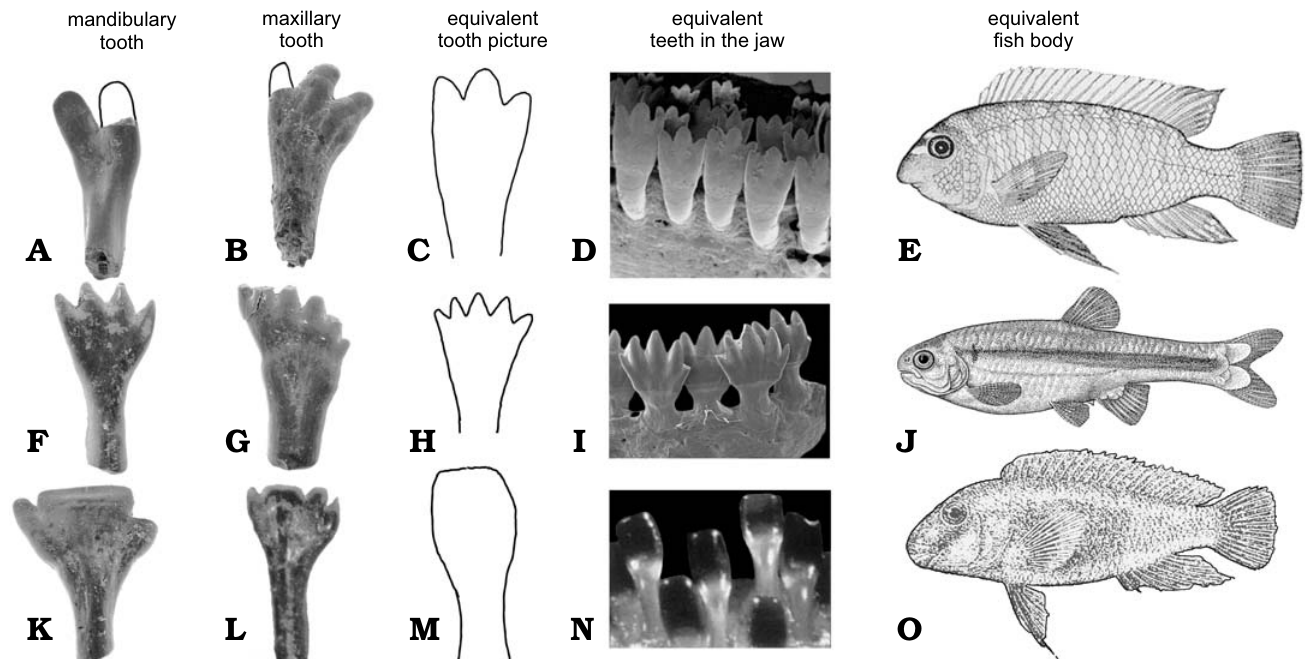
Fig. 3. Comparison of teeth of actinopterygian fish Isadia spp. from the Late Permian of Sokovka, Russia with their Recent equivalents. A , B . Isadia aristo viensis . C–E . Labeotropheus fuelleborni (C from Streelman et al. 2003; D, E from Abertson and Kocher 2006). F , G . Isadia suchonensis . H , J . Monotocheirodon kontos (from Menezes et al. 2013). I . Bryconamericus lethostigmus (from Hirschmann et al. 2017). K , L . Isadia arefievi . M – O . Eretmodus cyanosticus (M from Rüber et al. 1999; N, O from Boulenger 1915). Not to